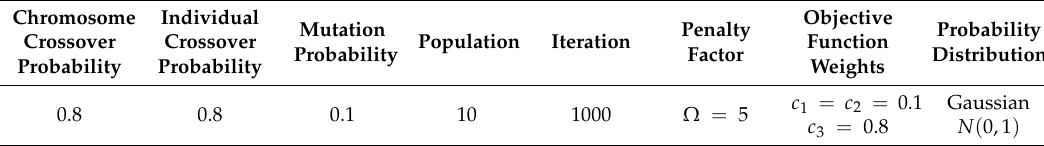
Table 6. Parameter settings for the algorithm.